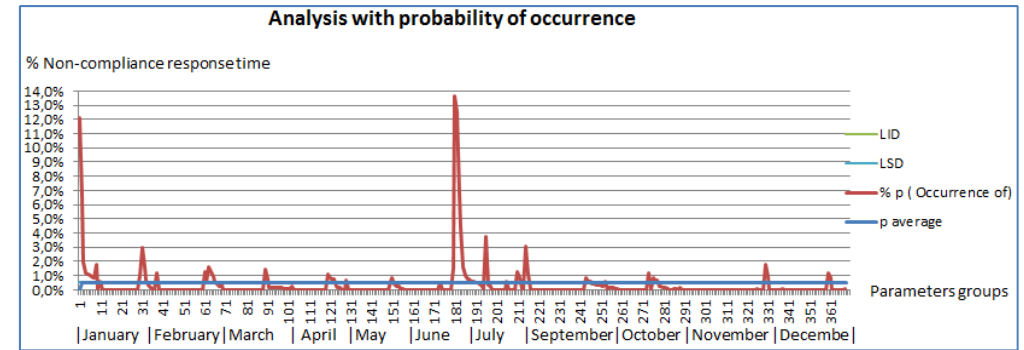
Figure 4. Analysis with probability of occurrence of low probability events according to Swertward [30]. Probability of occurrence of measurements that exceeded the turnaround time per parameter during the analyzed month.